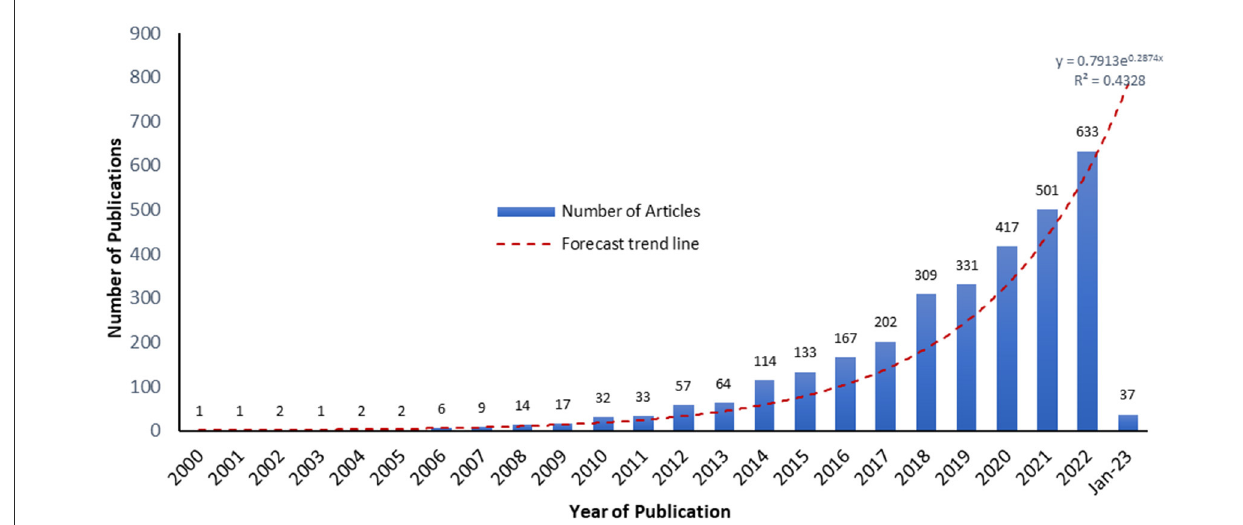
FIGURE2 Annual growth trajectory of literature on sustainable supply chain management.